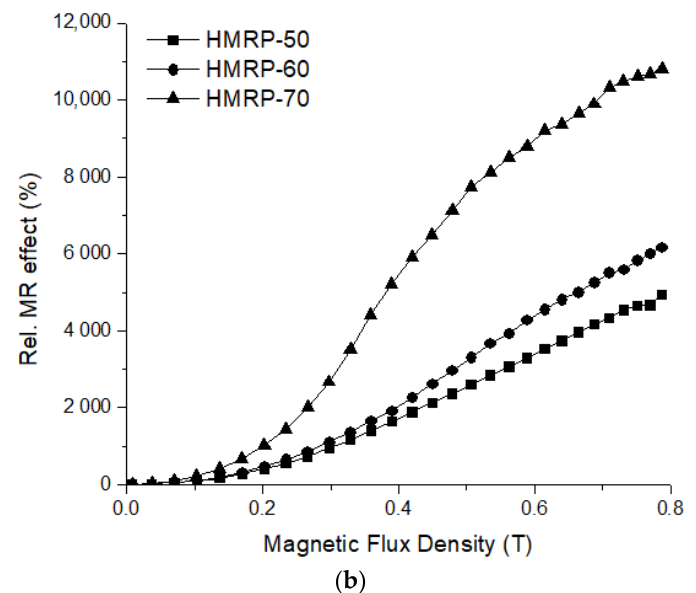
Figure 5. ( a ) Storage moduli and ( b ) relative magnetorheological (MR) effect of PVA HMRP samples with different CIP contents under different magnetic flux densities.